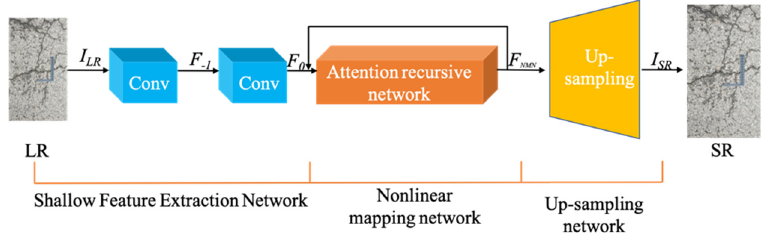
Figure 2. Generator structure with attention recursive network.